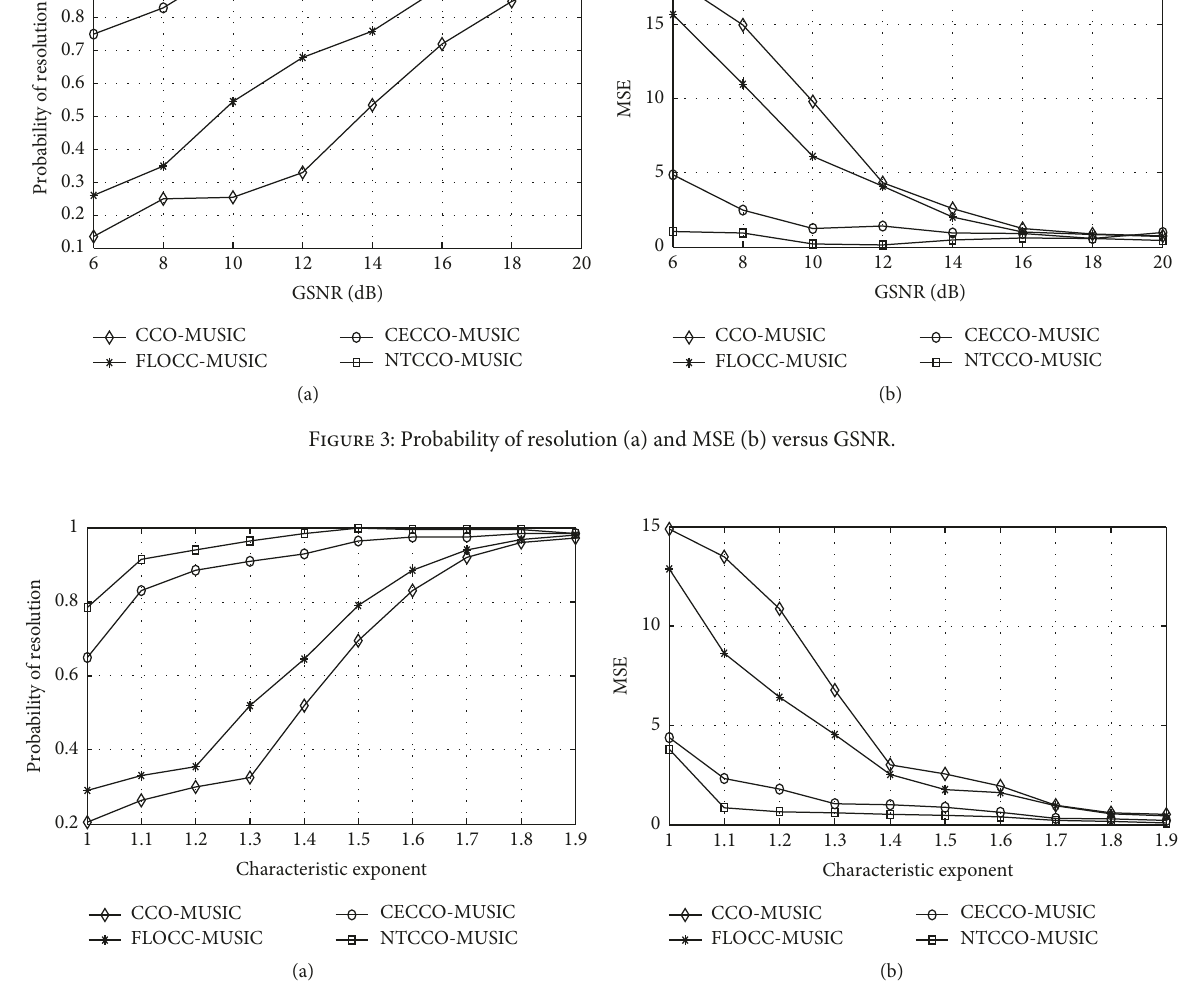
Figure 4: Probability of resolution (a) and MSE (b) versus characteristic exponent.